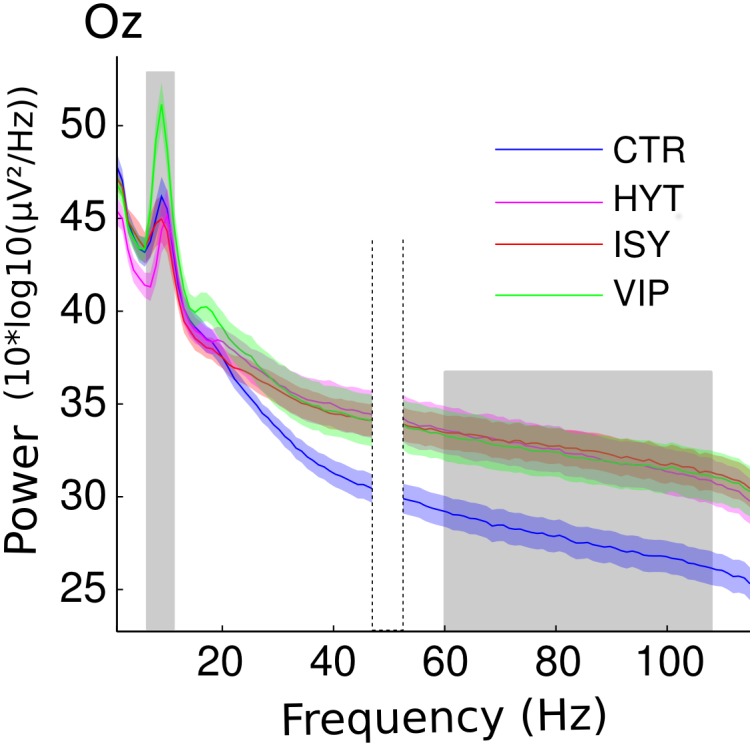
Spectral decomposition for occipital electrode Oz during the meditation condition in all 4 groups of subjects (CTR is the Control group; HYT is the Himalayan Yoga Tradition group; ISY is the Isha Shoonya Yoga group; VIP is the Vipassana group).Shaded regions indicate the standard error of the mean. The grey shaded area indicates the region of statistical differences between the groups after correction for multiple comparisons (see Material and Methods). The region around 50 Hz has been blanked out on the plot as it corresponds to line noise and has been excluded from analysis.